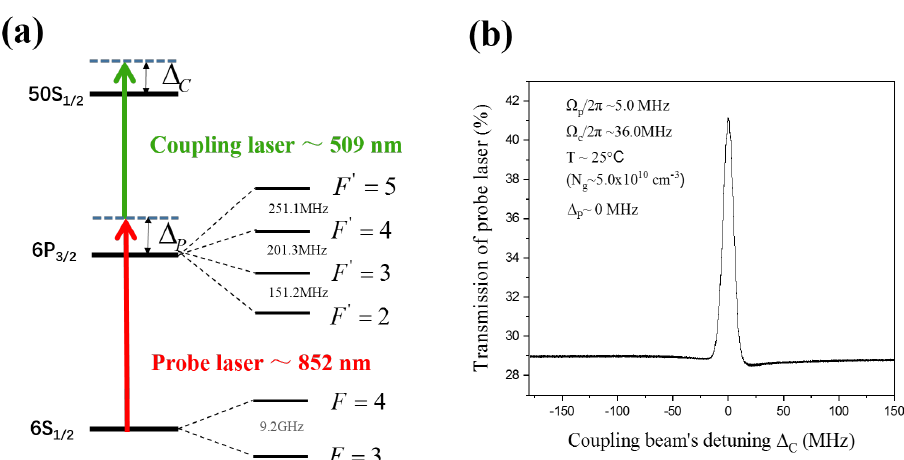
Figure 2. ( a ) Energy level schematic of the ladder-type EIT of Cs atoms with Rydberg state (50S 1/2 ). ∆ ∆ P is the detuning of probe laser, C is the detuning of coupling laser; ( b ) Typical Rydberg EIT signal. The 852-nm probe laser is detuned by ∆ P from the Cs 6 S 1/2 ( F = 4 ) → 6 P 3/2 ( F (cid:48) = 5 ) transition (here, ∆ P = 0), while the 509-nm coupling laser is scanned across the Cs 6 P 3/2 ( F (cid:48) = 5 ) → 50 S 1/2 Rydberg